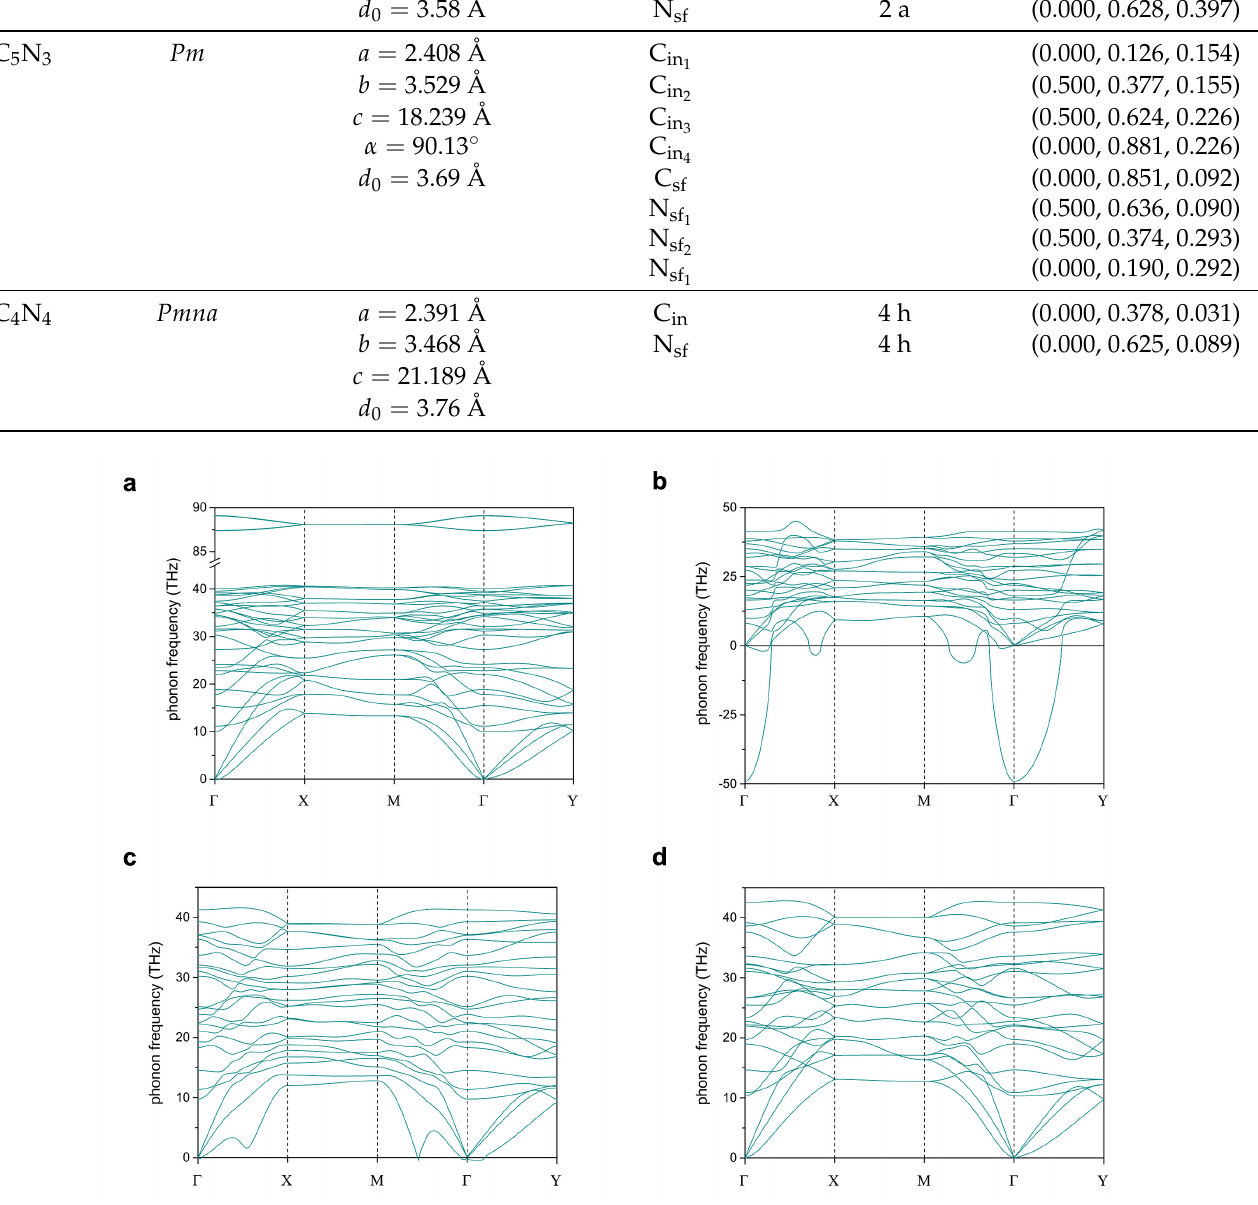
Figure 2. Phonon dispersions of ( a ) C 8 H 4 , ( b ) C 6 N 2 , ( c ) C 5 N 3 , and ( d ) C 4 N 4